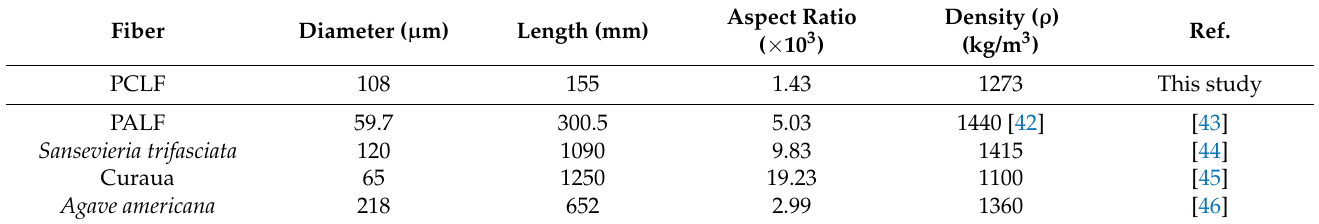
Table 2. Average physical properties of PCLF compared to other high-cellulose fibers.